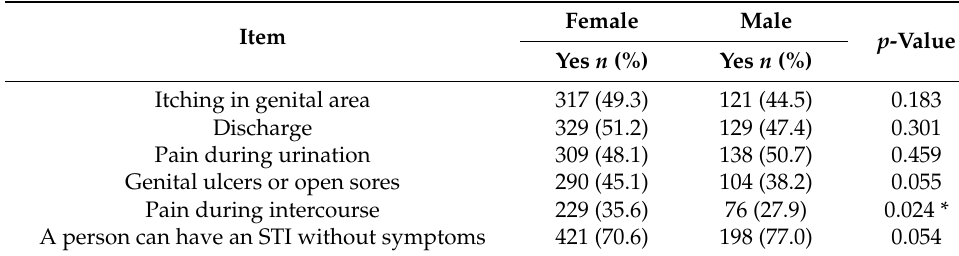
Table 4. Students’ knowledge of STI symptoms by